Question: From the figure, is the trend upward or downward?
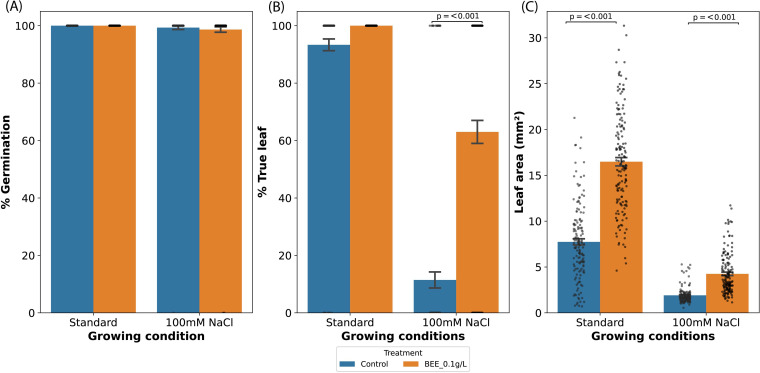
Answer: increasing